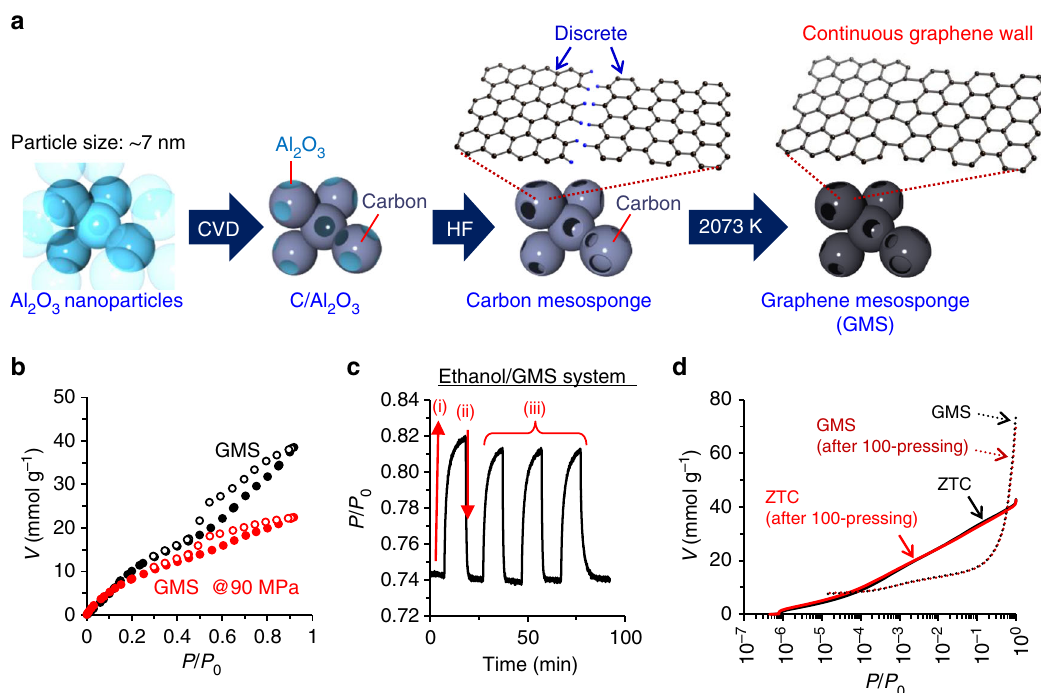
Fig. 5 Graphene mesosponge (GMS) for phase transition of ethanol (EtOH). a Synthesis scheme of GMS. Al 2 O 3 nanoparticles (particle size is ca. 7 nm) are uniformly covered with thin carbon layer by CVD. The carbon-coated Al 2 O 3 (C/Al 2 O 3 ) is washed with hydro fl uoric acid (HF) to remove Al 2 O 3 . The resulting carbon mesosponge is annealed at 2073 K to obtain GMS. The carbon microstructures of carbon mesosponge and GMS are depicted as insets in which black and blue spheres indicate carbon and hydrogen atoms, respectively. b EtOH adsorption – desorption isotherms (298 K) on GMS with (red symbols) and without (black symbols) compressing at ~90 MPa. Solid and blank symbols correspond to adsorption and desorption data, respectively. c Variations of the EtOH vapour pressure ( P / P 0 ) inside the press chamber observed in situ during applying/releasing a mechanical force to the GMS specimen. (i): GMS is pressed to release EtOH. (ii): GMS is recovered to re-adsorb EtOH. (iii): Repeated release/adsorption cycles. d N 2 adsorption isotherms (77 K) of ZTC and GMS before and after compressing them for 100 times at 83 MPa and 89 MPa, respectively. Solid and dotted lines correspond to the data of ZTC and GMS, respectively, while the data of pristine and compressed samples are shown by black and red